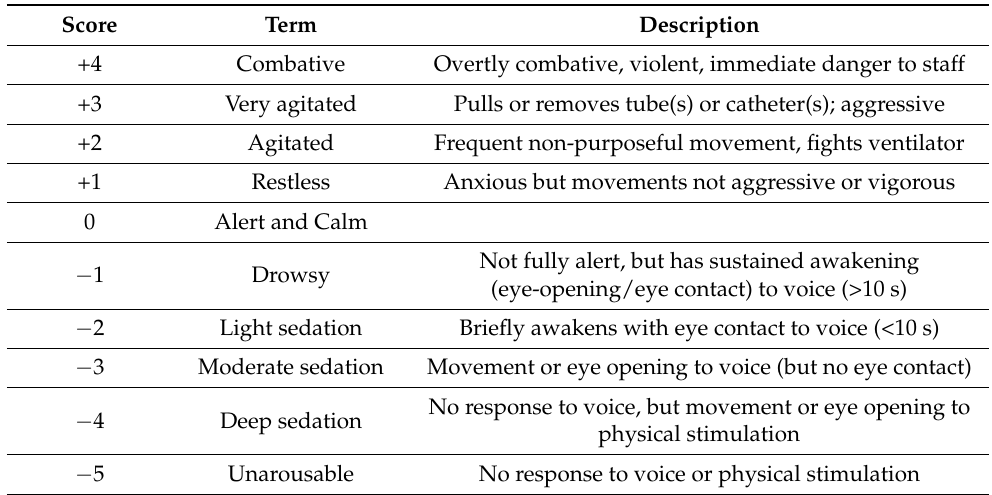
Table 2. Richmond Agitation-Sedation Scale (RASS). The Richmond Agitation and Sedation Scale is a validated and reliable method to assess patient’s level of sedation in the intensive care